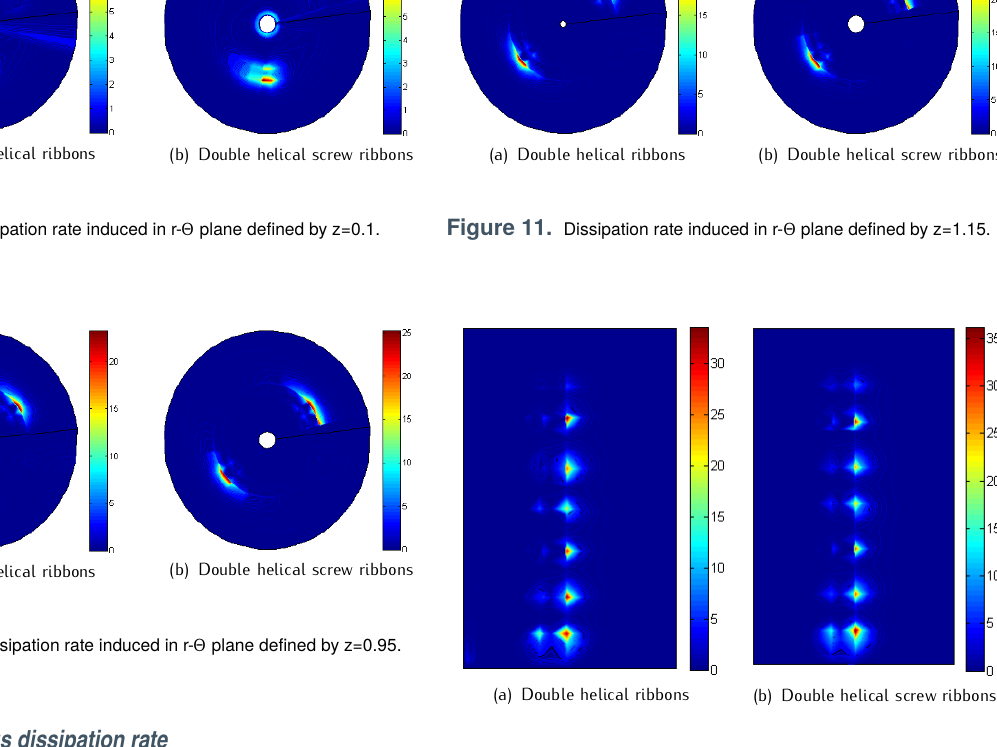
Θ plane defined by Θ =108 ◦